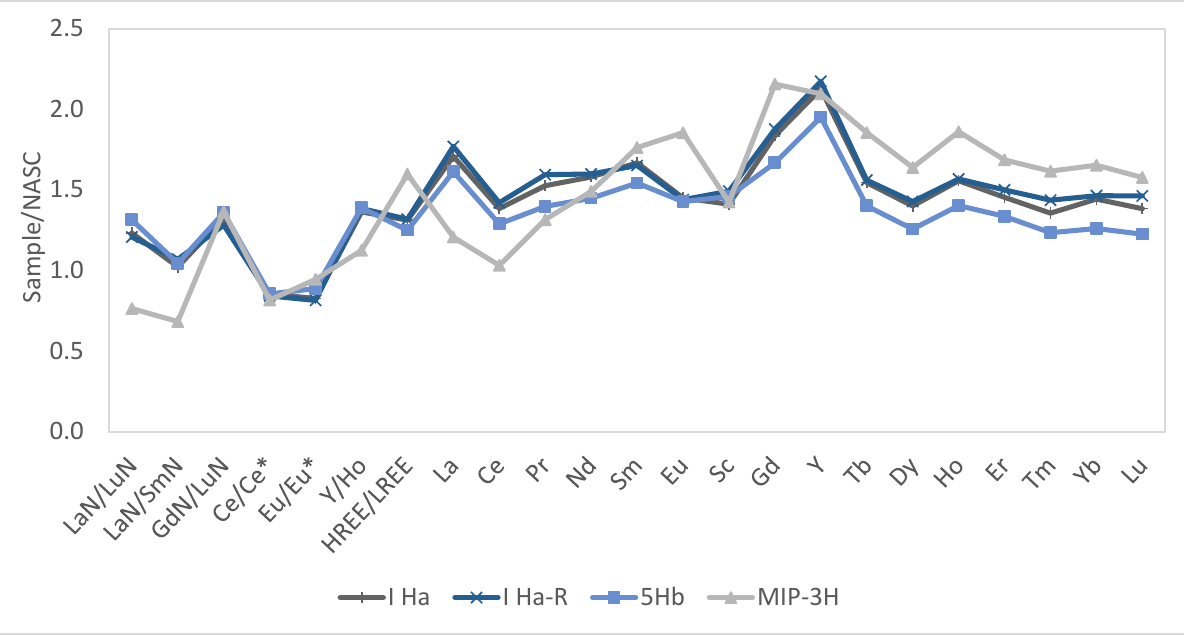
Figure 2. Whole-rock total REY distribution normalized to NASC and other indicators: La/Lu, La/Sm, Gd/Lu, Ce/Ce*, Eu/Eu*, Y/Ho, and HREE/LREE. XRD : The mineralogical composition of the whole rock is given in Table 2. The MIP-3H sample is dominantly composed of quartz (46%), mixed clays (22%), calcite (16%), pyrite (11%), and some dolomite (5%). The 1Ha Haynesville sample has a few more mineral phases in addition to the above, except for mixed clays and dolomite. It is approximately 28.8% quartz and 39% plagioclase and mica minerals. Calcite (12%), gypsum (0.4%), and pyrite (1.5%) are also present. XRD analyses showed that both samples are dominantly composed of silicates. Post-reaction XRD of residual samples showed signs of precipitation of neo-fluoride silicates due to reaction with HF. Additionally, kalicinite (KHCO 3 ) was detected only in MIP-3H Marcellus Shale, which has a high TOC of